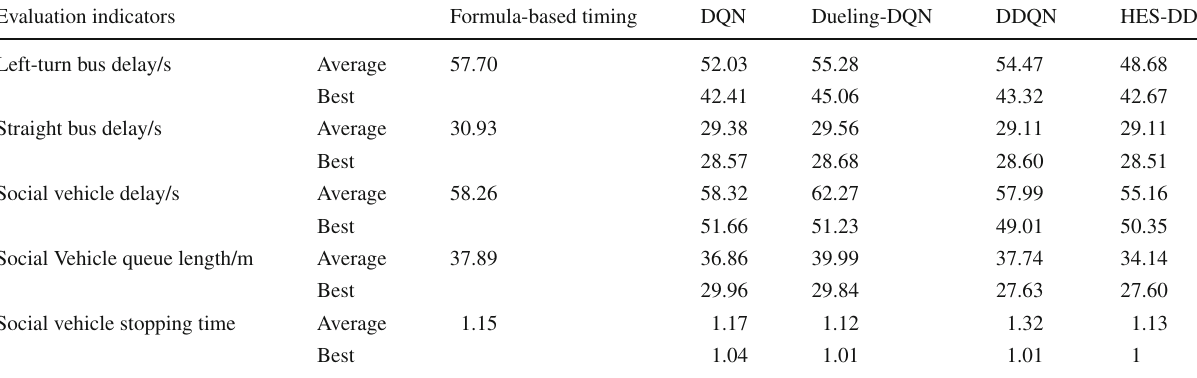
Table 4 Experimental results based on Zhuhai data set Evaluation